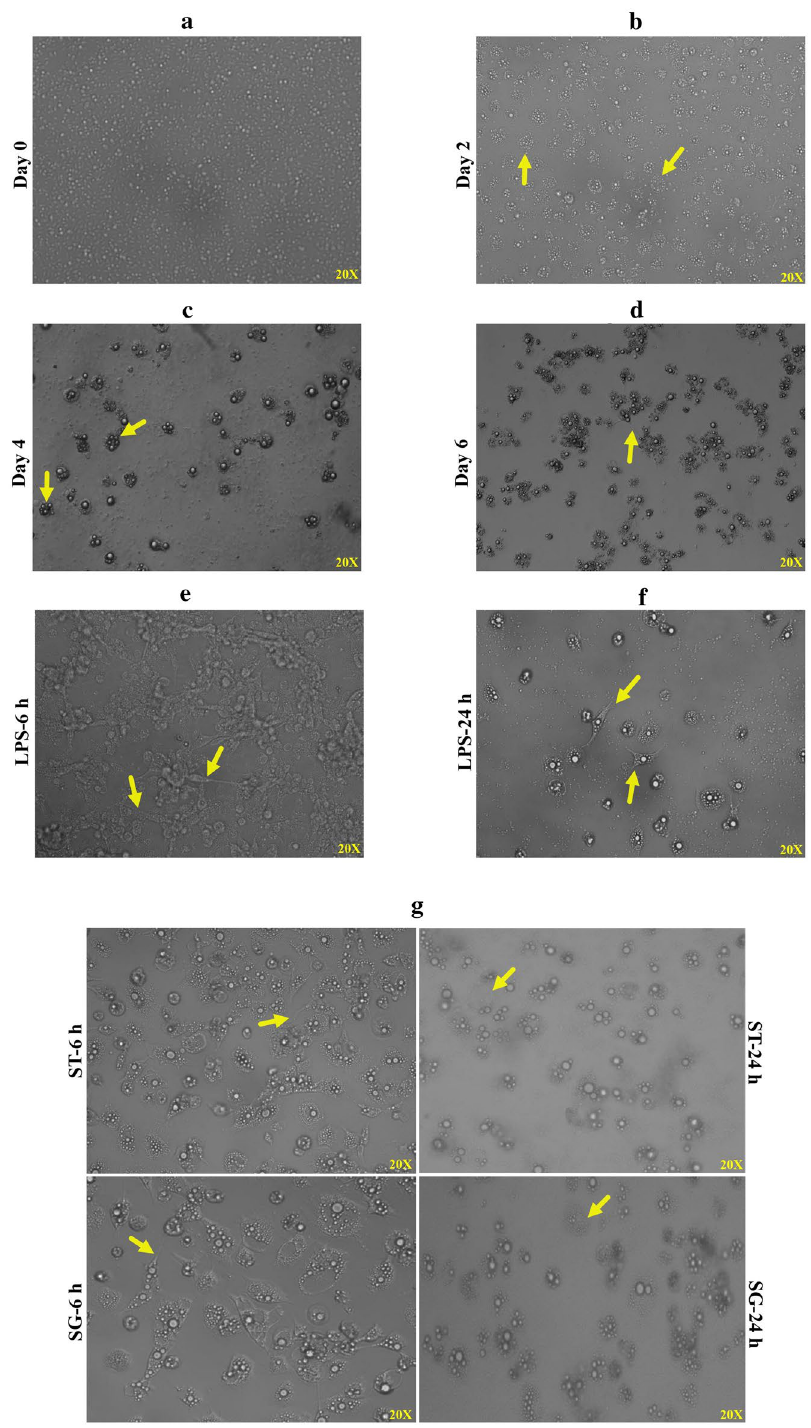
Figure 1. Morphology of chicken blood monocyte derived dendritic cells (chMoDCs) observed directly from cell culture plates using an inverted light microscope at ×200 magnification. Peripheral blood mononuclear cells (PBMCs) culture supplemented with recombinant chicken GM-CSF at 25 ng/mL and IL-4 at 12.5 ng/mL concentration followed by induction of maturation on 6th day using Salmonella LPS (1 µg/mL) for 24 h. ( a ) PBMCs were plated at a concentration of 2 × 10 6 cells/mL. ( b ) Cell aggregates started to form. ( c ) Individual cell aggregates were distinctly evident. ( d ) Cells were firmly adhered with a network of dendrites started to form. ( e ) After 6 h of LPS stimulation, formation of extensive network of dendrites resembling typical cell morphology was evident. ( f ) After 24 h of LPS stimulation, drastic reduction in dendrite sizes were apparent. ( g ) chMoDCs infected with S . Gallinarum and S . Typhimurium at a multiplicity of infection of 10 showed typical cell morphology with extensive dendrites at 6 h post-infection, however during late phase of infection (24 h), cellular damage was evident as cells were found to be missing from within the cell aggregates with complete loss of